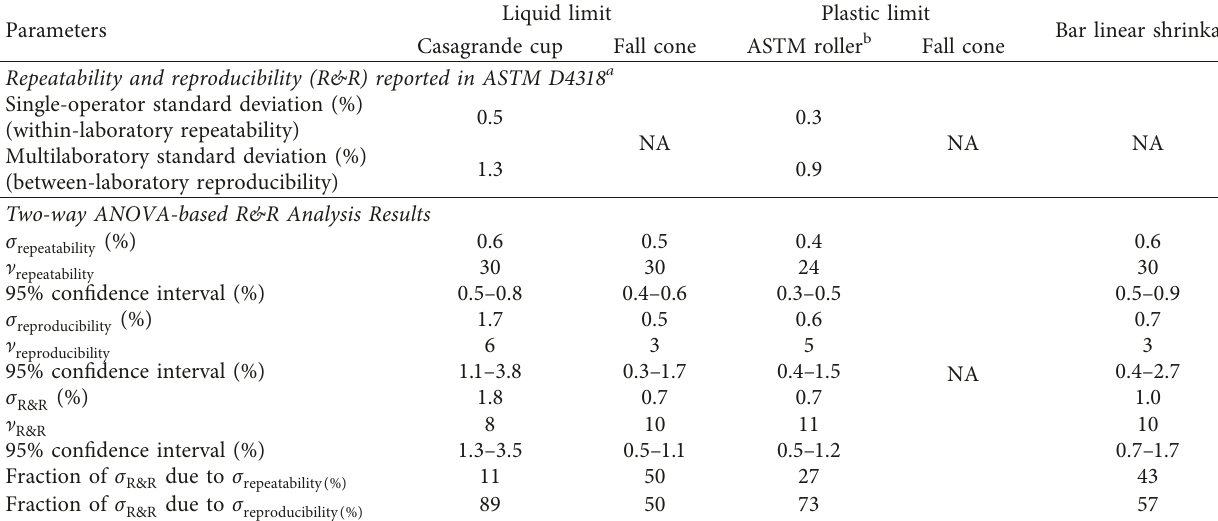
Table 7: Repeatability and reproducibility results reported in ASTM D4318 and determined by two-way ANOVA-based analysis for the various laboratory